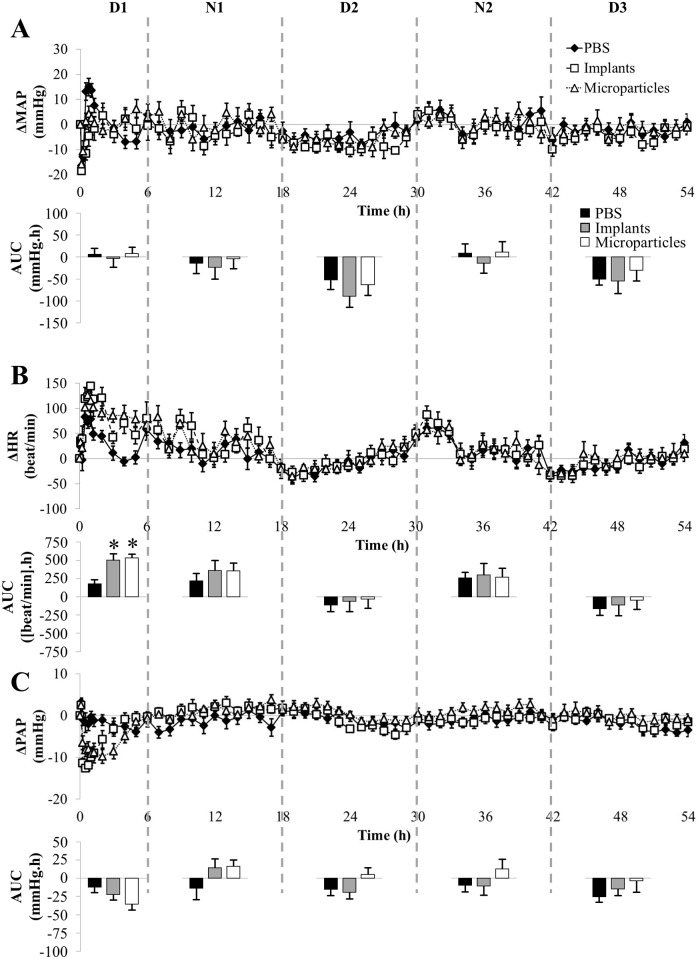
Impact of formulated GSNO at 7.5 mg/kg on MAP (panel A), HR (panel B) and PAP (panel C).Each animal (n = 7) received all the treatments (Implants: 7.4 ± 0.2; Microparticles: 7.7 ± 0.2 mg/kg). Day-night cycles are marked in days (D1, D2 and D3) and nights (N1, N2) periods. For more clarity, after the first hour, only one point for each hour was represented. *: p < 0.05 vs. PBS (one-way ANOVA; post-hoc Bonferroni test).